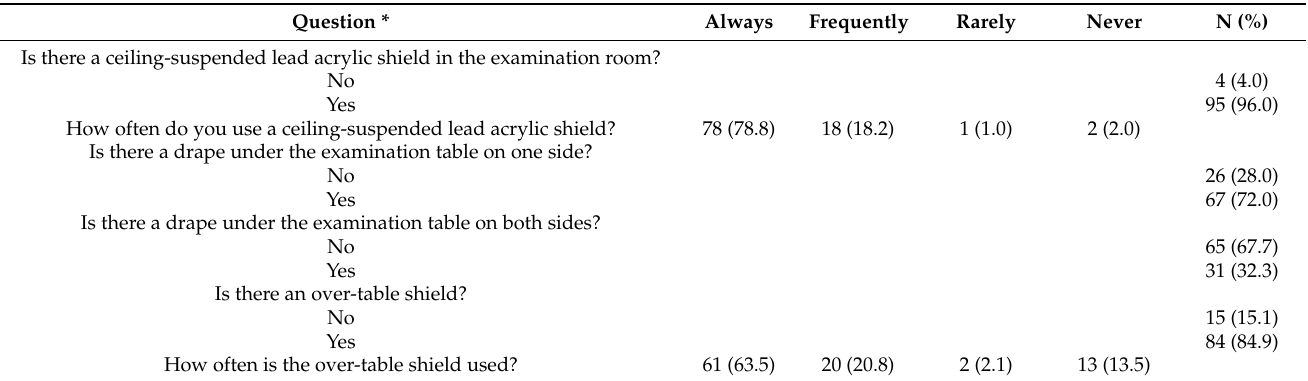
(Table 2). Of the respondents, 95 stated that the examination rooms were fitted with a ceiling-suspended lead acrylic shield. Just four participants replied that there was no ceiling-suspended lead acrylic shield in the operating room. When asked “How often do you use a ceiling-suspended lead acrylic shield?” 78 participants replied “always” and 18 responded with “frequently” (Table 3). Table 3. Information on the availability and use of interventional installations.